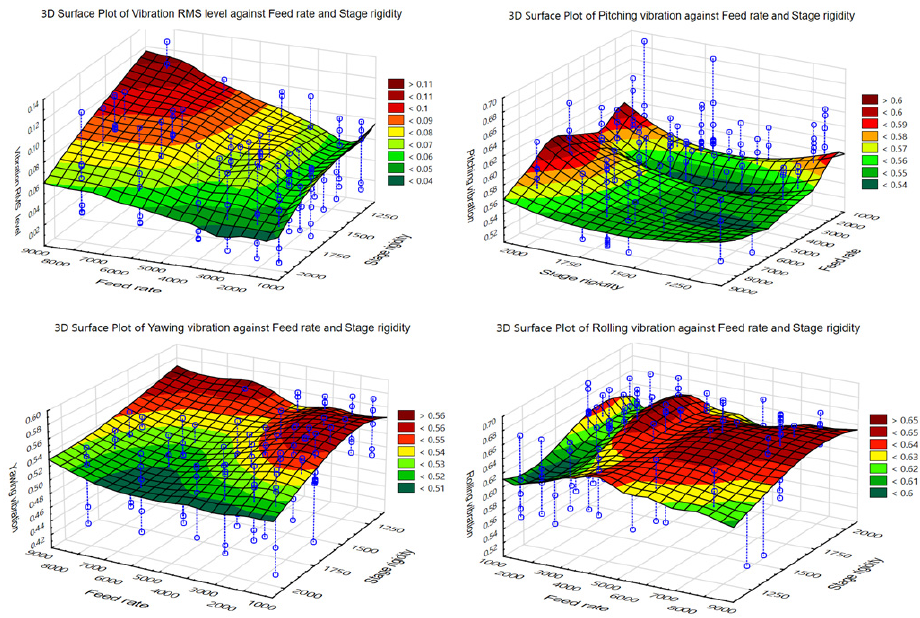
Figure 13. Response surfaces of vibration RMS levels against the stage rigidity and feed rate.